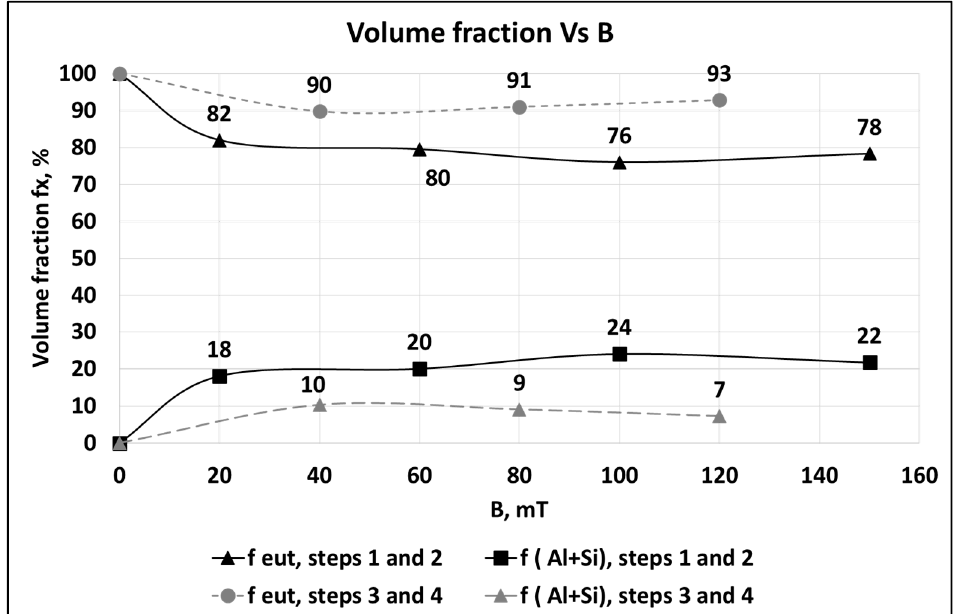
Figure 7. The volume fraction of the eutectic structure and primary phases (primary aluminum and silicon) during the solidification experiments steps with changing magnetic induction B.